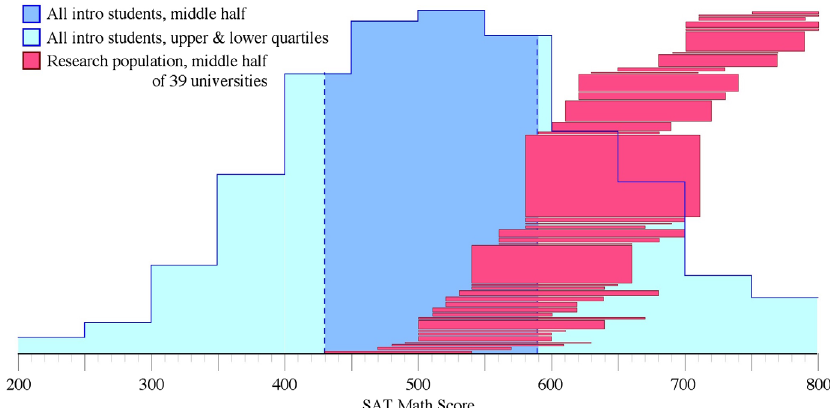
FIG. 3. Comparison of middle half SAT Math scores for all students with those of incoming freshmen at universities where most PER is conducted. The blue-shaded histogram gives the distribution of SAT Math scores for all students taking the SAT in 2008 [22], the last year that the College Board released these data in 50-point bins. The dashed vertical blue lines represent the 25th percentile score (430) and the 75th percentile (590) scores for all students; with the middle half shaded a darker blue than the lowest and highest quarters. The 39 stacked rectangles shaded in red are the 25th – 75th percentile ranges for incoming freshmen at the universities whose students comprise 95% of all university students in our study. The horizontal span of each rectangle in the stack represents the middle half of incoming freshman students for a single university, with the height of that rectangle giving the proportional representation from that university of all students in our